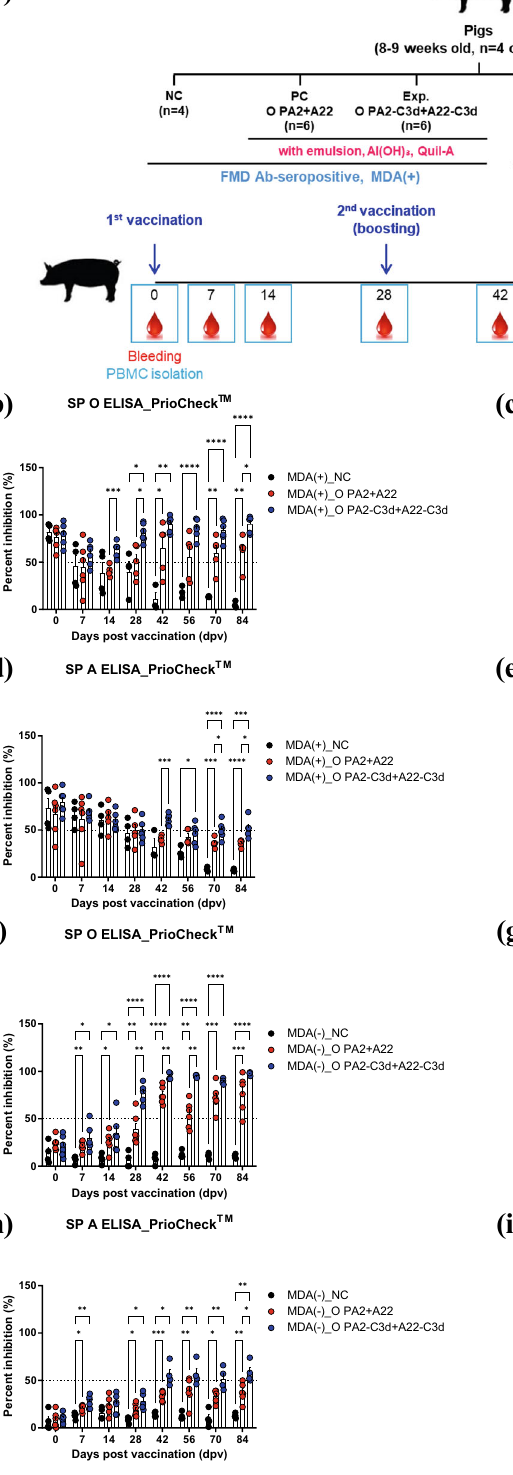
signi fi cantly different between the experimental and NC groups ( p < 0.05) (Fig. 7k, l). The expression levels of the co-stimulatory molecules were lower compared to the overall expression levels of the cytokines, but were signi fi cantly higher in the experimental group than in